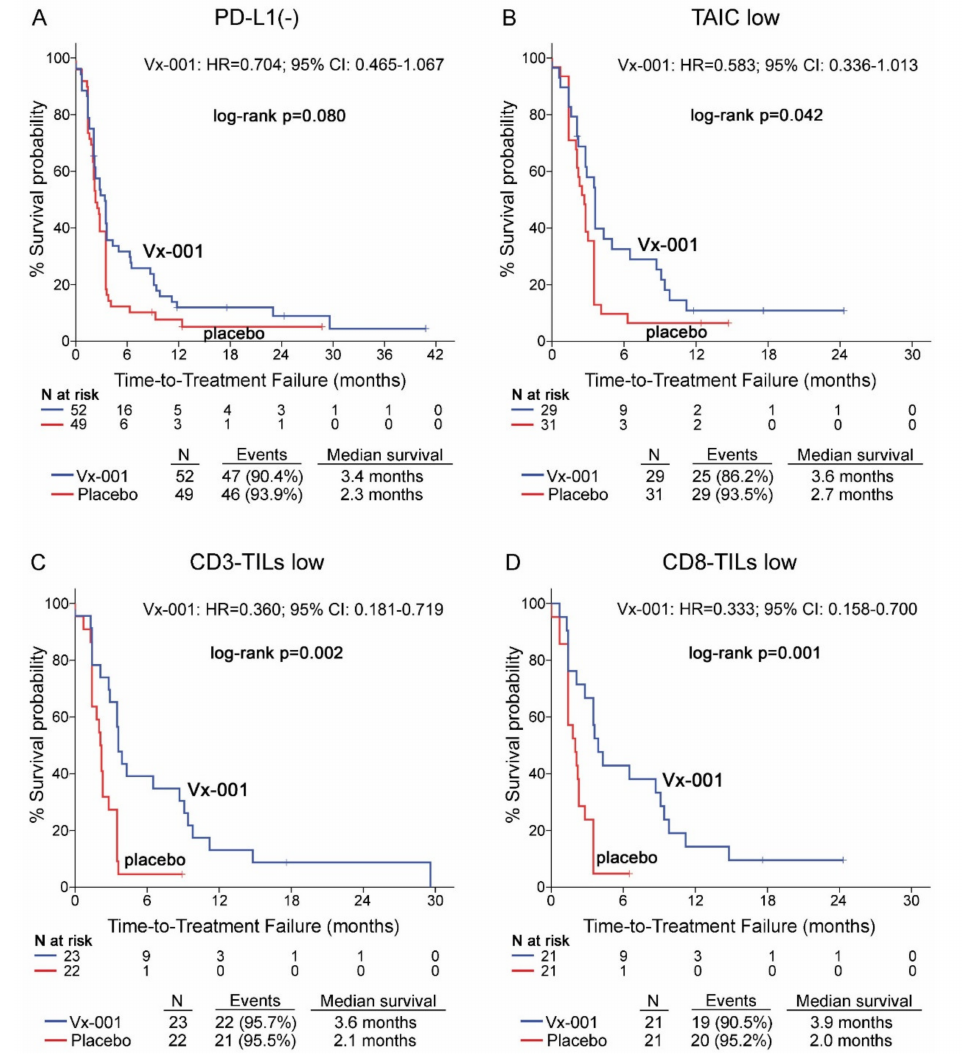
Figure 3. Time to treatment failure (TTF) in patients with PD-L1(-), TAIC low, CD3-TIL low and CD8-TIL low tumors. TTF was measured in patients with PD-L1(-) ( A ), TAIC low ( B ), CD3-TIL low ( C ) and CD8-TIL low ( D )